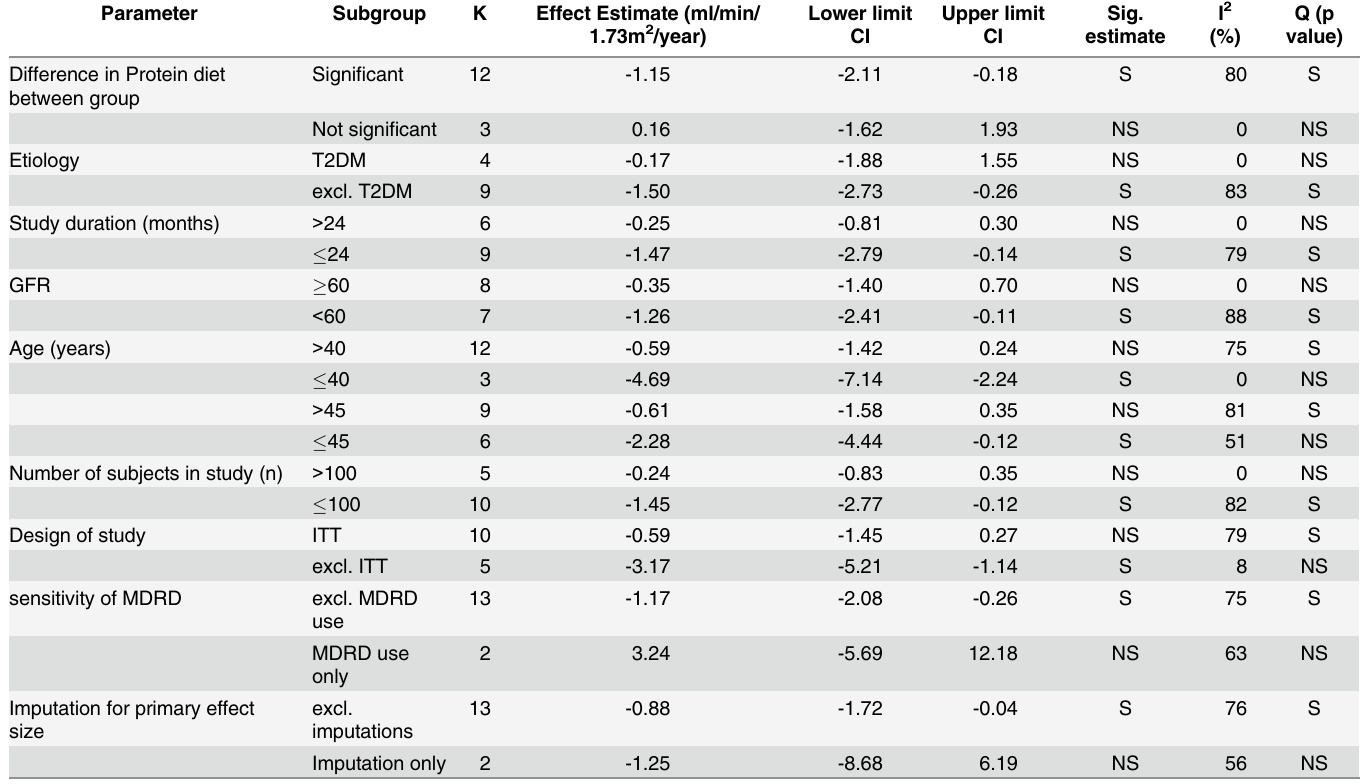
Table 4. Results of the subgroup and sensitivity analyses a .